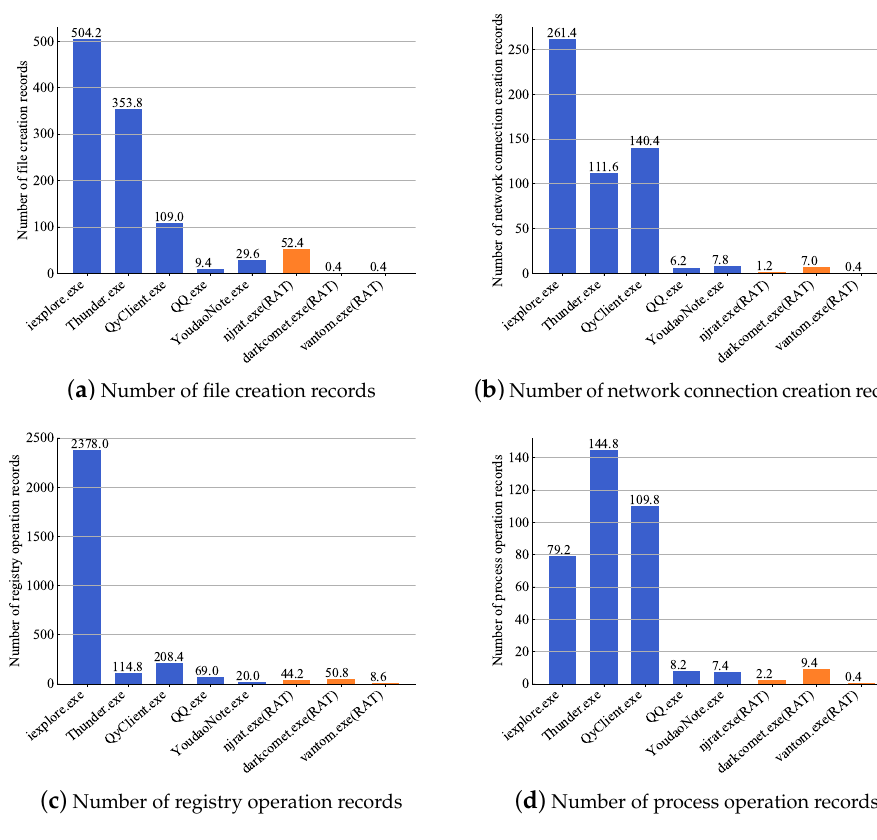
Figure 4. Some characteristics of several benign programs and RATs on host